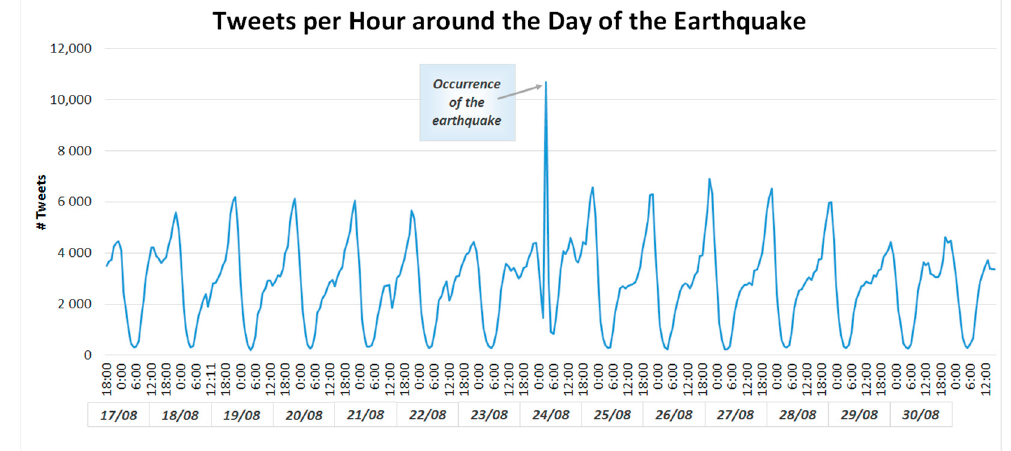
Figure 6. Example histogram is showing clear peaks on the frequency of tweets associated with the 2014 South Napa earthquake [74].